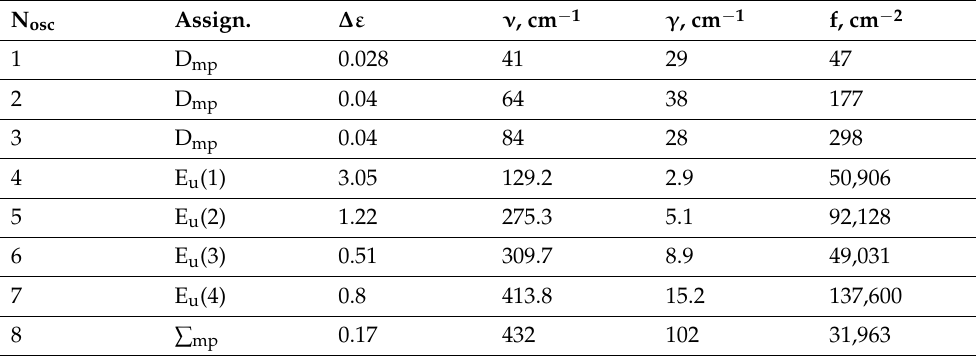
Table 2. Parameters of oscillators simulating the absorption bands of the LiGdF 4 single crystal for E ⊥ c. ε ∞ = 2.25(4) n = 1.50(1).